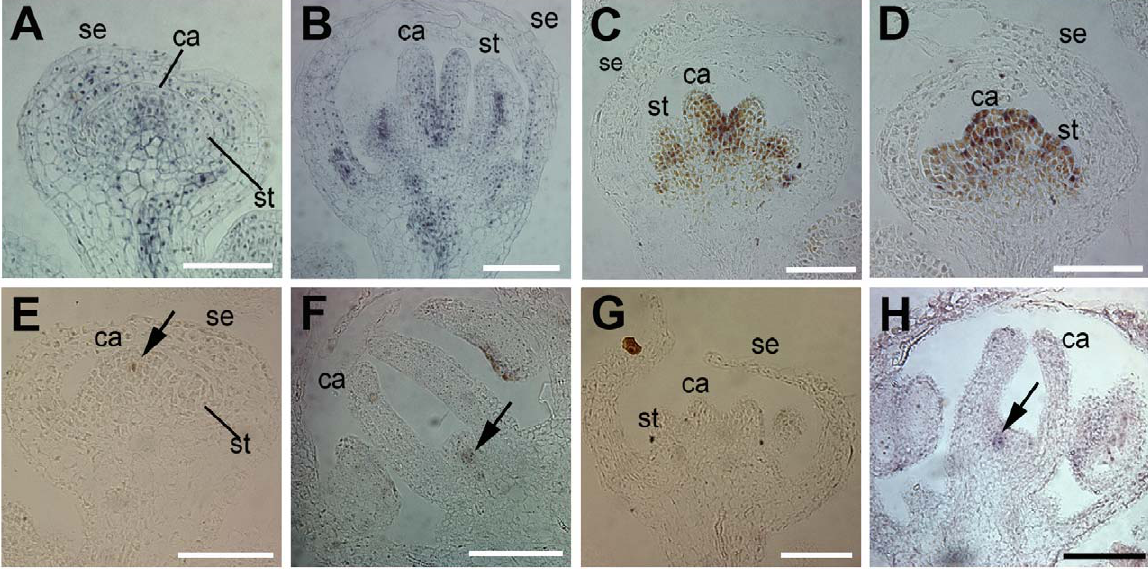
Figure 3. Expression patterns of AGO10 , AG , and WUS in floral meristems. (A, B) Immunolocalization of AGO10 protein using anti-GFP antibodies in zll-1 pZLL::YFP-ZLL flowers. The grey signals represent AGO10. Before floral stage 6, AGO10 was predominantly localized at the floral meristem and in provascular tissue (A); AGO10 was adaxialized in carpels beyond stage 6 (B). (C, D) The ago10-13 mutation did not alter the spatial patterns of AG expression in developing flowers. AG mRNA was similarly present in the inner two whorls of an ag-10 (C) and an ag-10 ago10-13 (D) flower at stages 6–7. (E–H) ago10 mutations led to prolonged WUS expression. In hua1 hua2 , the latest stage when WUS mRNA could be detected was stage 6 (E). WUS expression persisted to stages 8-9 in hua1 hua2 ago10-12 flowers (arrow in F). WUS expression was diminished by stage 7 in ag-10 (G). In ag-10 ago10-13 , WUS expression could be observed in stages 8–9 flowers (arrow in H). Scale bars, 50 m m. ca, carpel; se, sepal; st, stamen.